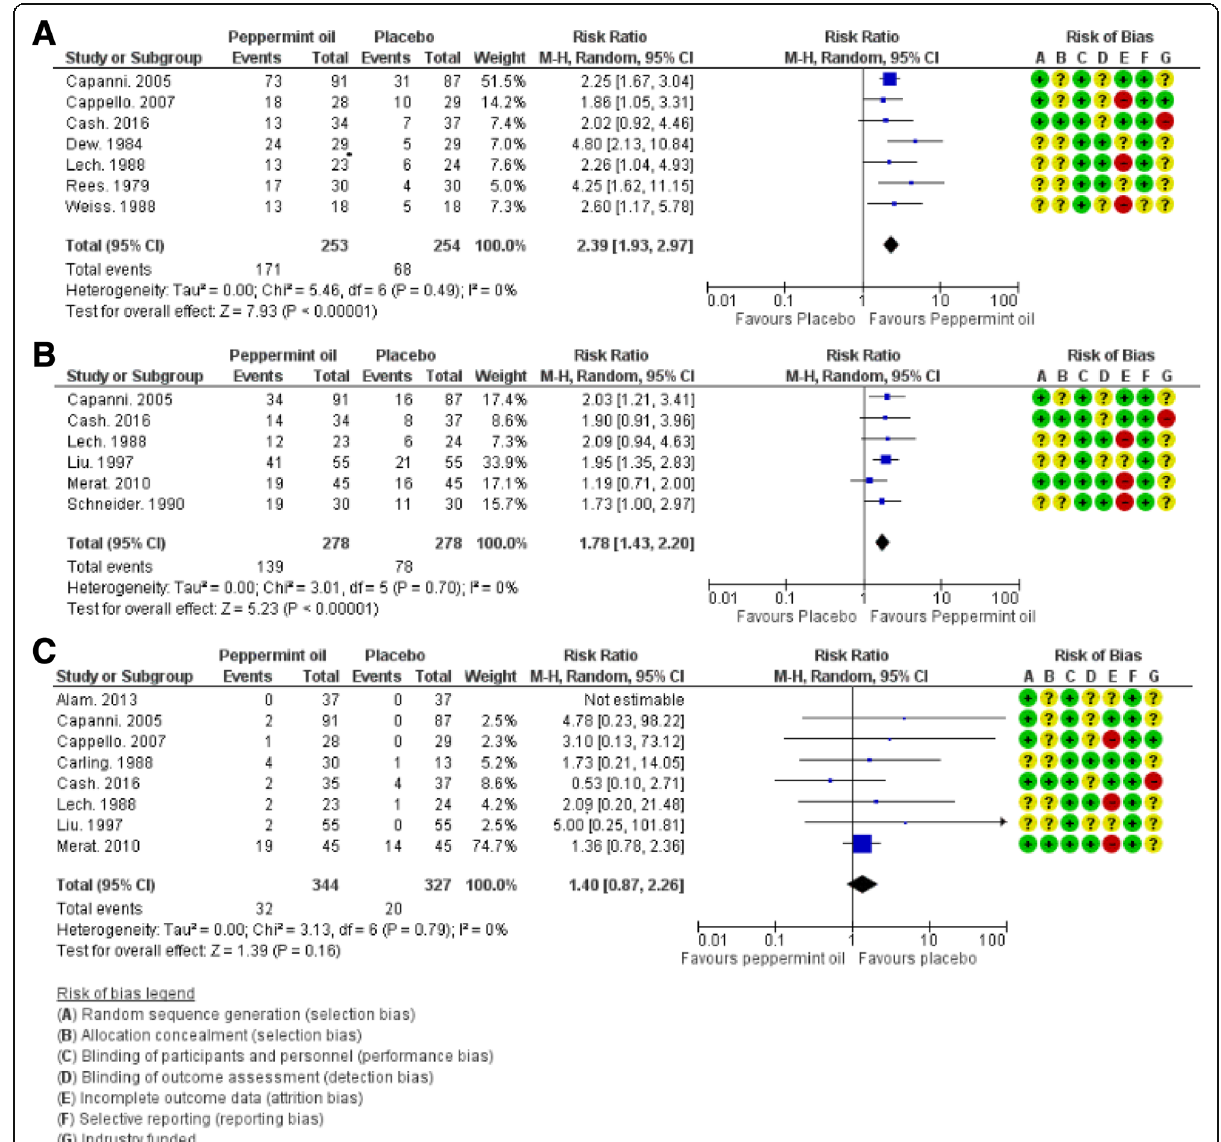
Fig. 3 a - c . Forrest Plots of Meta-analysis of Enteric-Coated Peppermint Oil for the treatment of Irritable Bowel Syndrome. The results of our meta- analysis of the randomized controlled trials of enteric-coated peppermint oil (PO) versus placebo for the irritable bowel syndrome (IBS) are shown in a-c . a illustrates the results of the meta-analysis of treatment outcomes for seven included studies for the global improvement of IBS symptoms vs. placebo [20, 22, 31, 33 – 35, 37]. a . illustrates the risk ratio (RR) for seven RCTs for the effect of enteric-coated PO ( n =253) versus placebo ( n =254) on global symptoms was 2.39 [95% confidence interval (CI): 1.93, 2.97], I 2 =0%, z=7.93 ( p <0.00001). b . displays the results of the meta-analysis of the reported treatment outcomes for the improvement in abdominal pain vs. placebo for six included studies [22, 31, 32, 34, 36]. The RR for six RCTs for the effect of enteric-coated PO ( n =278) versus placebo ( n =278) on abdominal pain was 1.78 [95% CI: 1.43, 2.20], I 2 =0%, z=5.23 ( p <0.00001). c illustrates the results of the meta-analysis of eight included studies [22, 29 – 32, 34, 35, 38] of the reported adverse effects in IBS subjects using EPO (32 events, 344 total, 9.3%) versus placebo (20 events, 327 total, 6.1%); RR 1.40 [95% CI: 0.87, 2.26] I 2 =0%, z=1.39 ( p =0.16). Figure 3a-c show their corresponding risk of bias analysis. (A) Random sequence generation (selection bias); (B) Allocation concealment (selection bias); (C) Blinding of participants and personnel (performance bias); (D) Blinding of outcome assessment (detection bias); (E) Incomplete outcome data (attribution bias); (F) Selective reporting (reporting bias); (G) Industry funded. The risk of bias is displayed as low risk (green, +), unclear (yellow, ?), or high risk (red, −